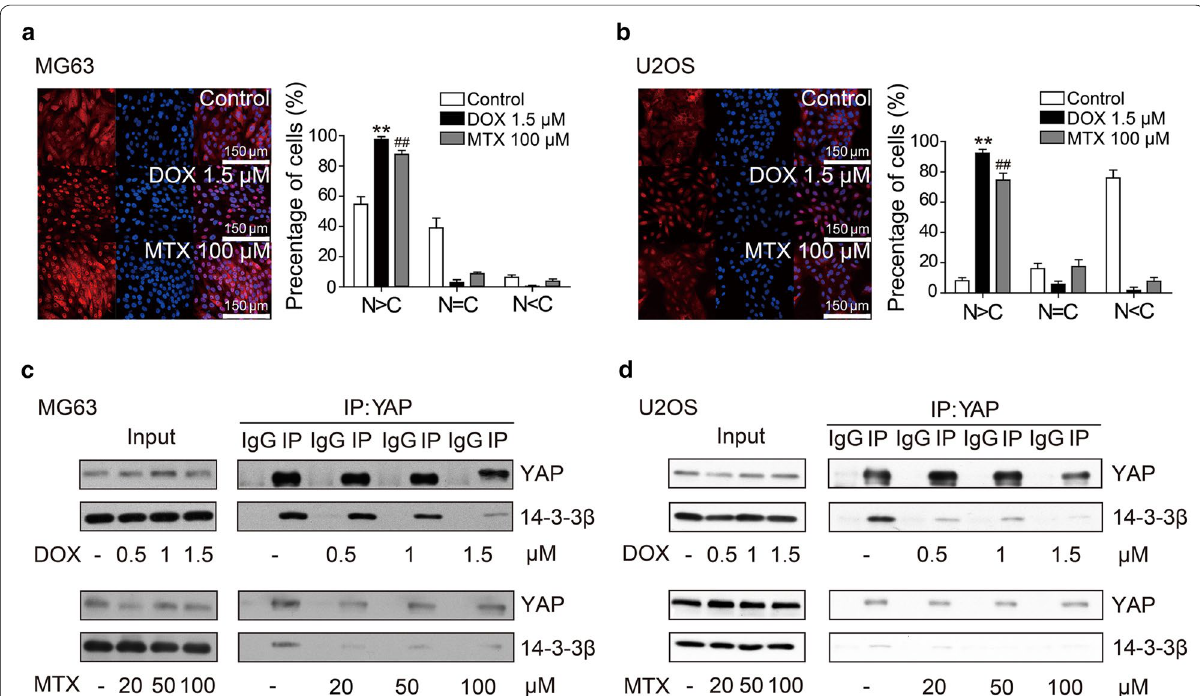
Fig. 4 MTX and DOX induce YAP nucleus translocation. a , b MG63 and U2OS cells cultured on coverslips were exposed to MTX (100 μM) or DOX (1.5 μM) for 24 h. Endogenous YAP was stained using an anti‑YAP antibody ( red ), and nuclei were stained with DAPI ( blue ). The subcellular localiza‑ tion of YAP was quantified ( lower panels ). The error bars represent mean SD. Compared with control ( N nucleus; C cytoplasm. t test, n 100), ± = ** P < 0.01, ## P < 0.01. Results show that MTX and DOX promoted YAP nuclear translocation. c , d Co‑immunoprecipitation was applied to investigate the interaction between YAP and 14‑3‑3β in MG63 and U2OS cells. Cells were exposed to indicate concentrations of MTX or DOX for 24 h before co‑immunoprecipitation. The results were determined by western blotting and the interaction between YAP and 14‑3‑3β was decreased by